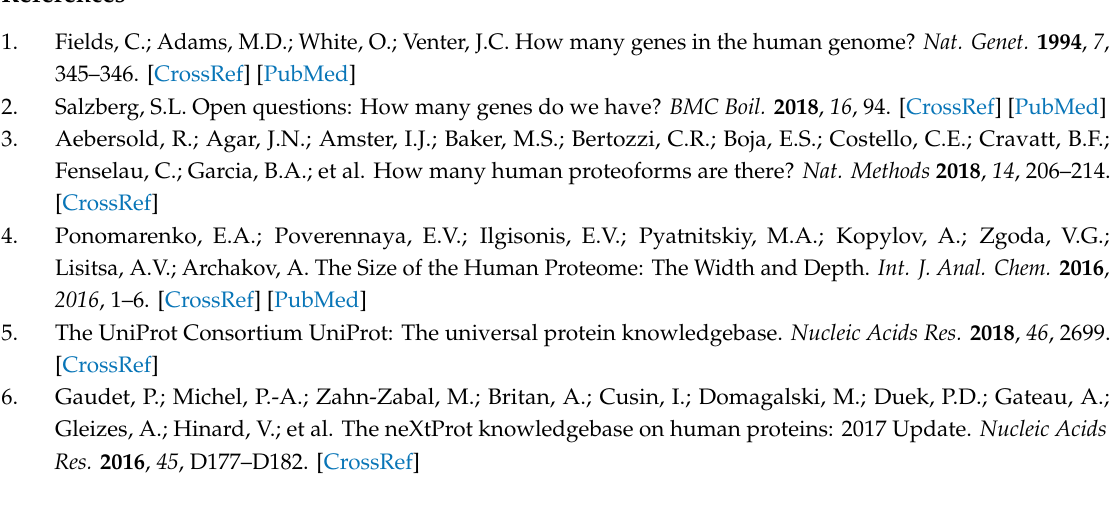
s1. Figure S1: Distribution of identified proteins: canonical, alternative spliced or master form. Figure S2: (a) distribution of identified proteins which were used as baits in their canonical form in BioPlex; (b) distribution of identified proteins which were used as baits in their alternative spliced form in BioPlex.) Figure S3: Evaluation of optimal threshold for Dice and Hart scoring schemes. Figure S4: Identified functional clusters based on coincidence of the interactomic profiles. Orange color highlights canonical variants of uPE1 proteins, yellow color—splice forms of uPE1 proteins, dark and light green indicate canonical and splice forms encoded by one uPE1 gene, correspondingly, uPE1 proteins represented only by splice forms are also marked with green. Figure S5: Example of di ff erent functional annotation for two proteoforms. Table S1: Predicted GO categories for uPE1 proteins (confirmed at the proteomic level, but without functional annotation). Table S2: List of 31 human genes encoded functionally distinct to